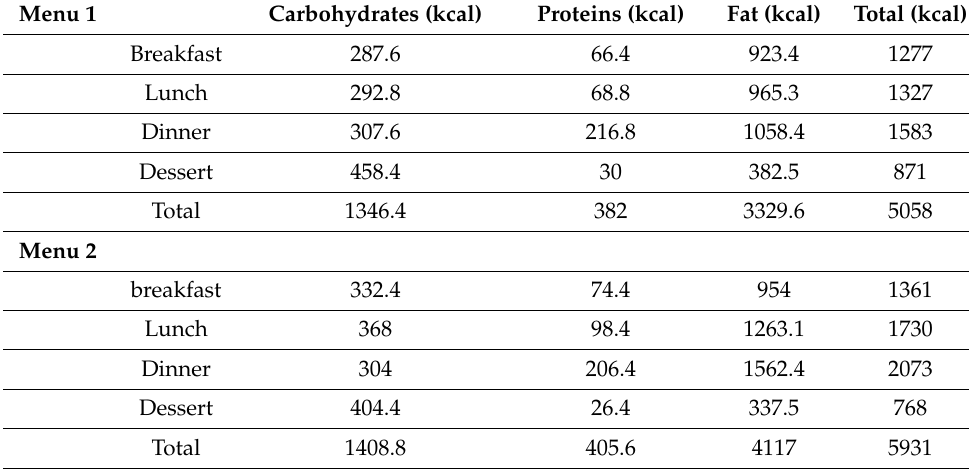
Table 1. The energy content (kilocalories) of the different daily meals for the two menus used during the